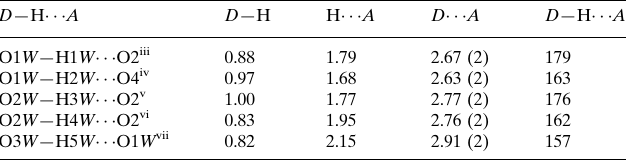
Hydrogen-bond geometry (A˚ , (cid:4)